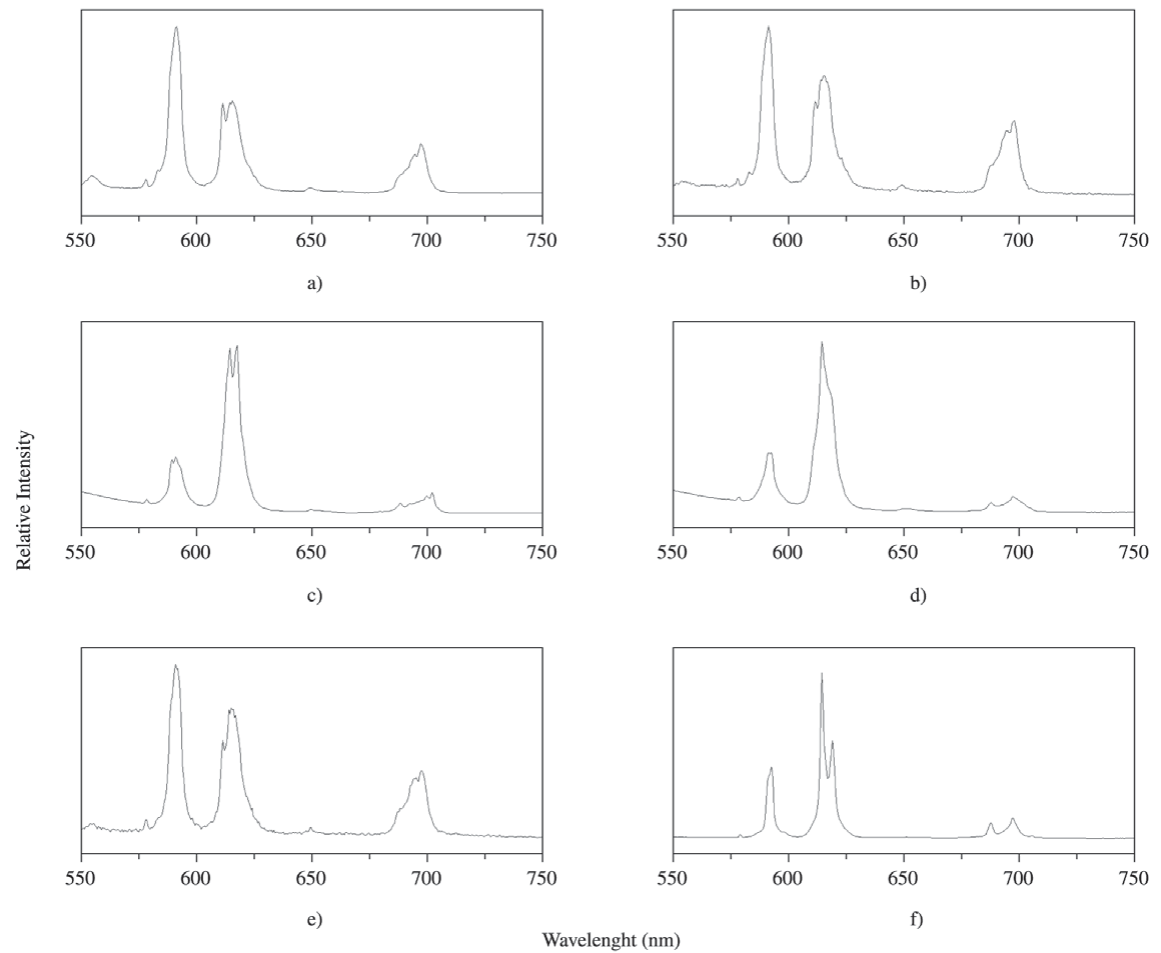
λ = 393 nm; b) TEOSEu(bpy)Cl 3 exc λ =317 nm; f) TEOSAPTSEu(bpy)Cl 3 exc